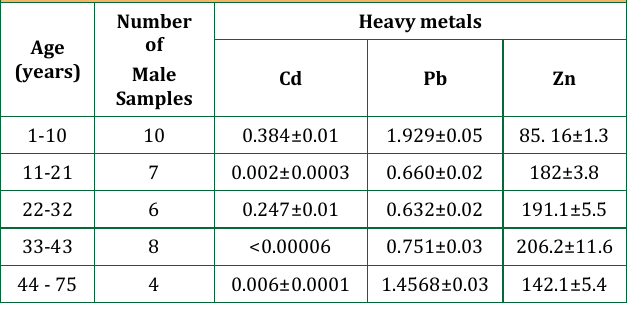
Table 1: Mean Concentration (mg/kg±SD) of Heavy Metal in Male Samples by Age